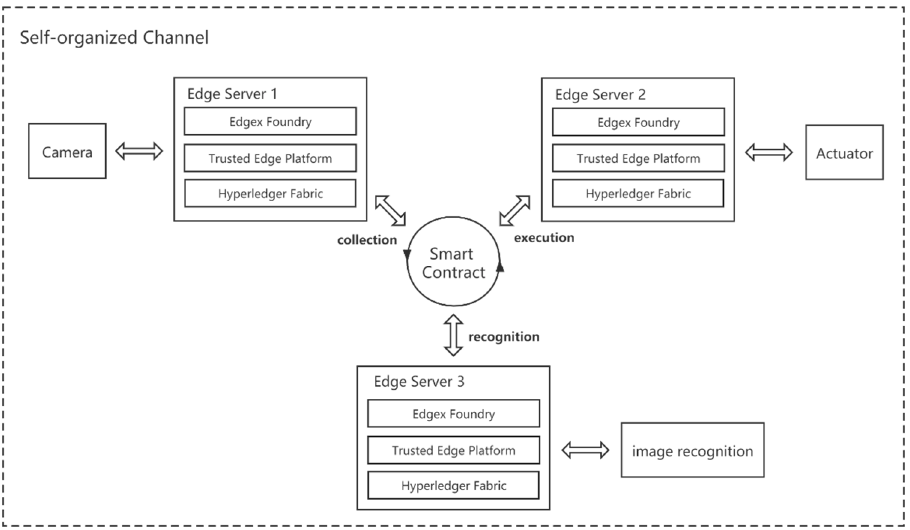
Figure 9. Schematic diagram of collaboration experiment between multiple nodes.